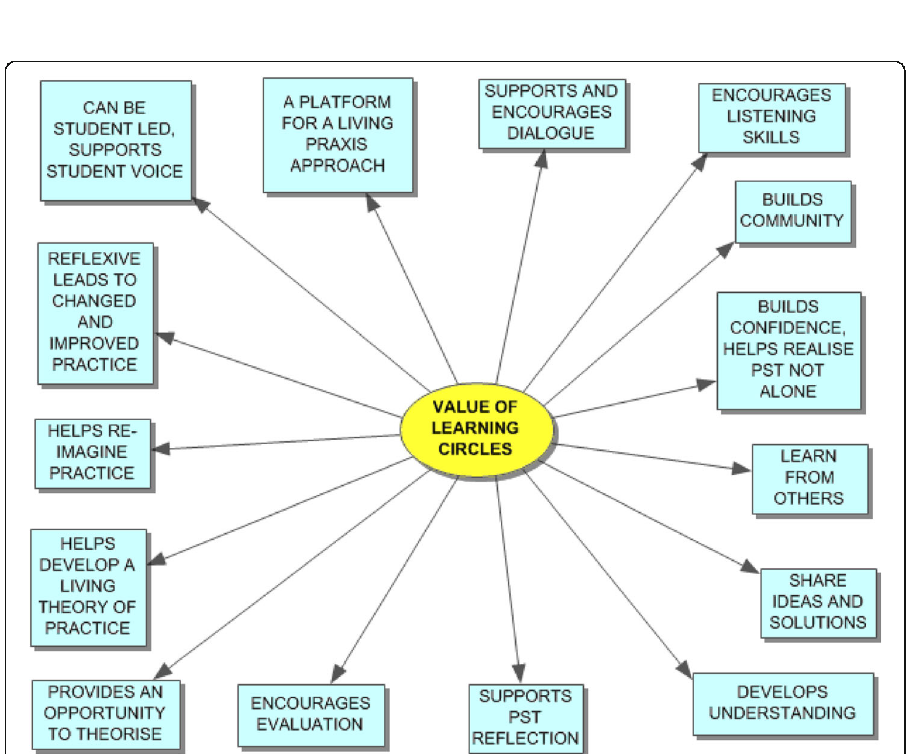
Fig. 2 The Value of Learning